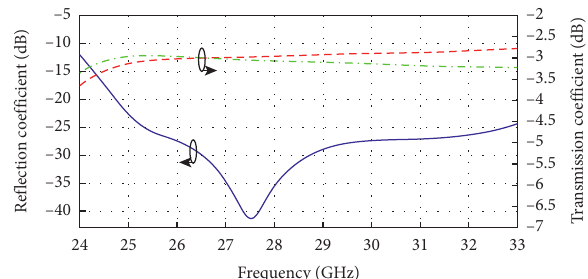
Figure 11: The simulated reflection and transmission coefficient of the E -probe transition between feed-1 and